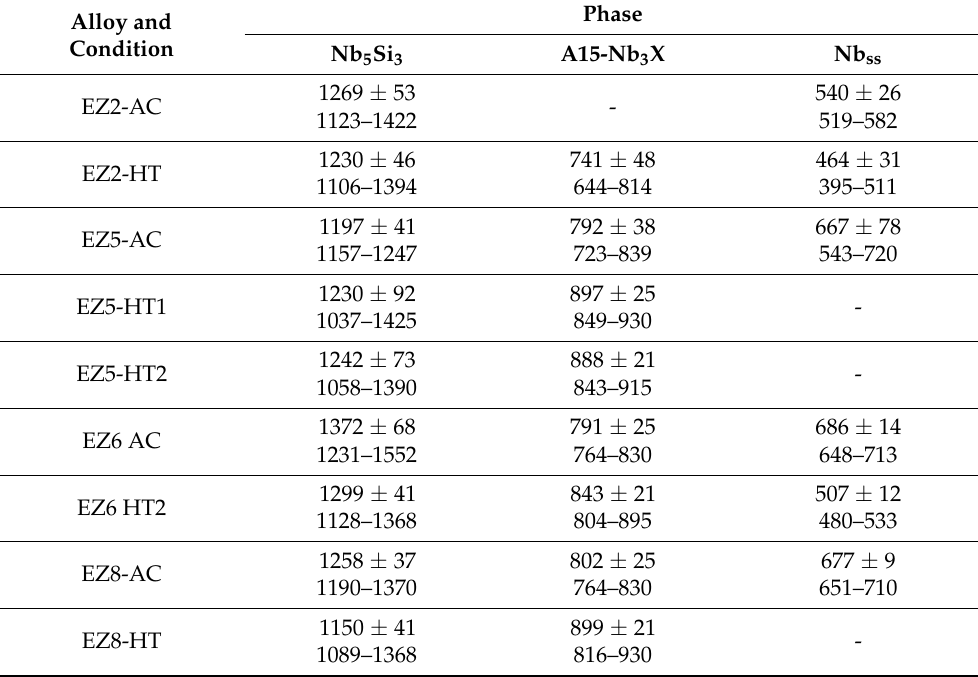
Table 4. Hardness data of the phases in the alloys EZ2, EZ5, EZ6, and EZ8. Alloy and Condition